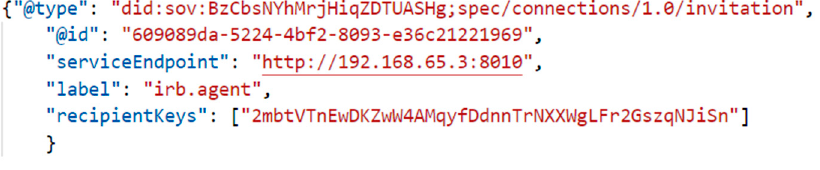
Figure 10. JSON format of IRB invitation